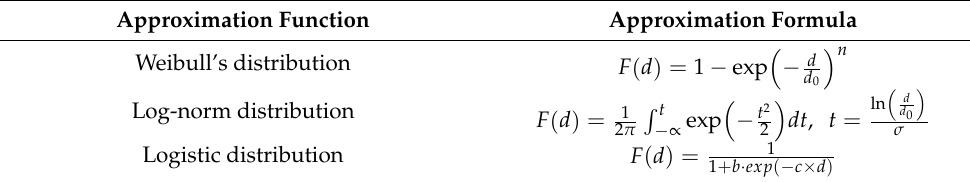
Table 2. Approximation functions used in fitting and the obtained